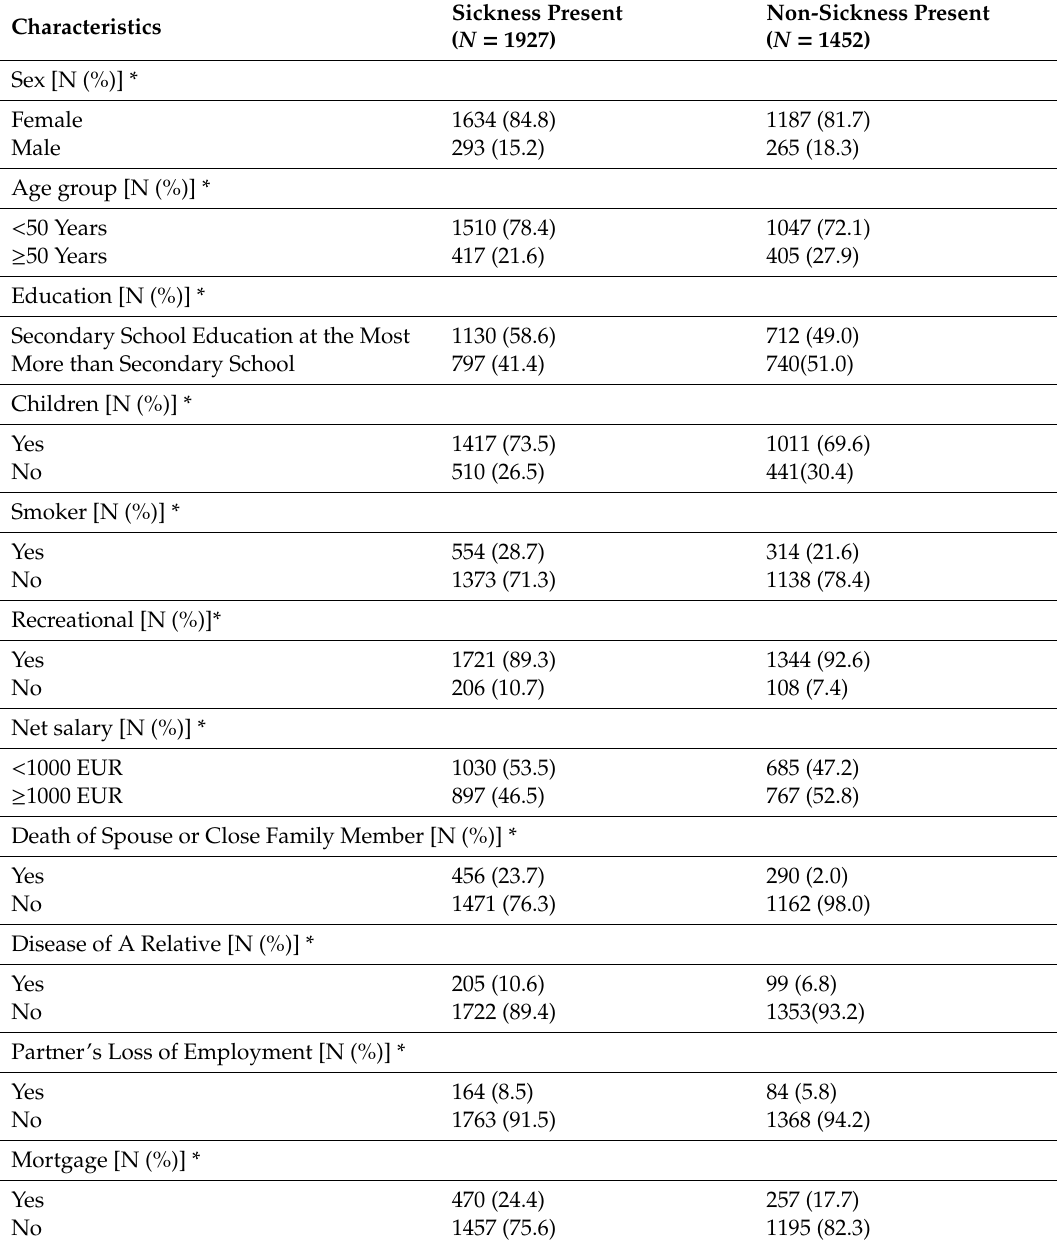
Table 1. Socio-demographic characteristics and life events of the study